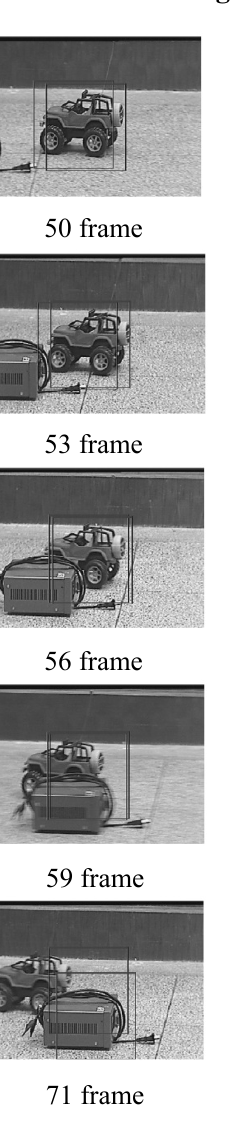
Figure 10. Tracking with the traditional